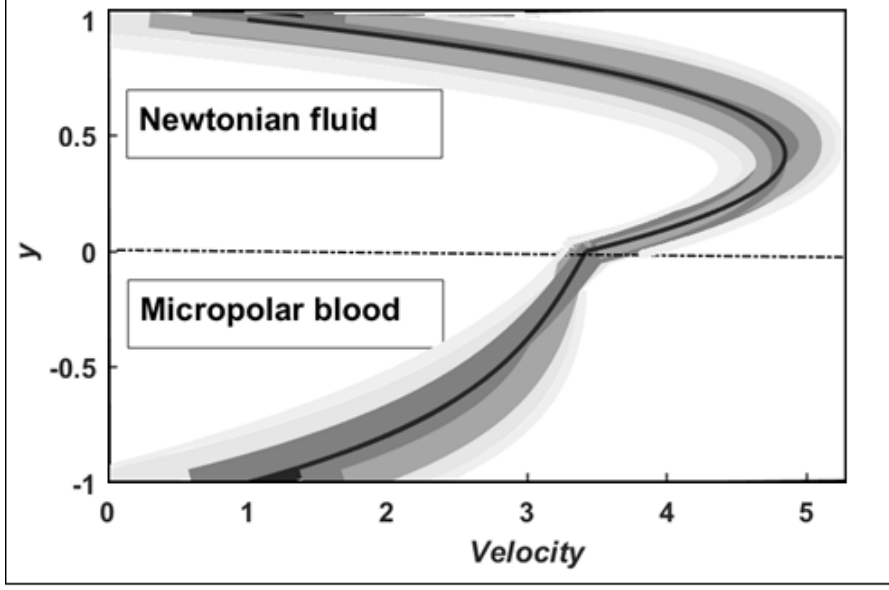
Figure 7. Grayscale image of fuzzy solution for velocity profile with the fuzzy